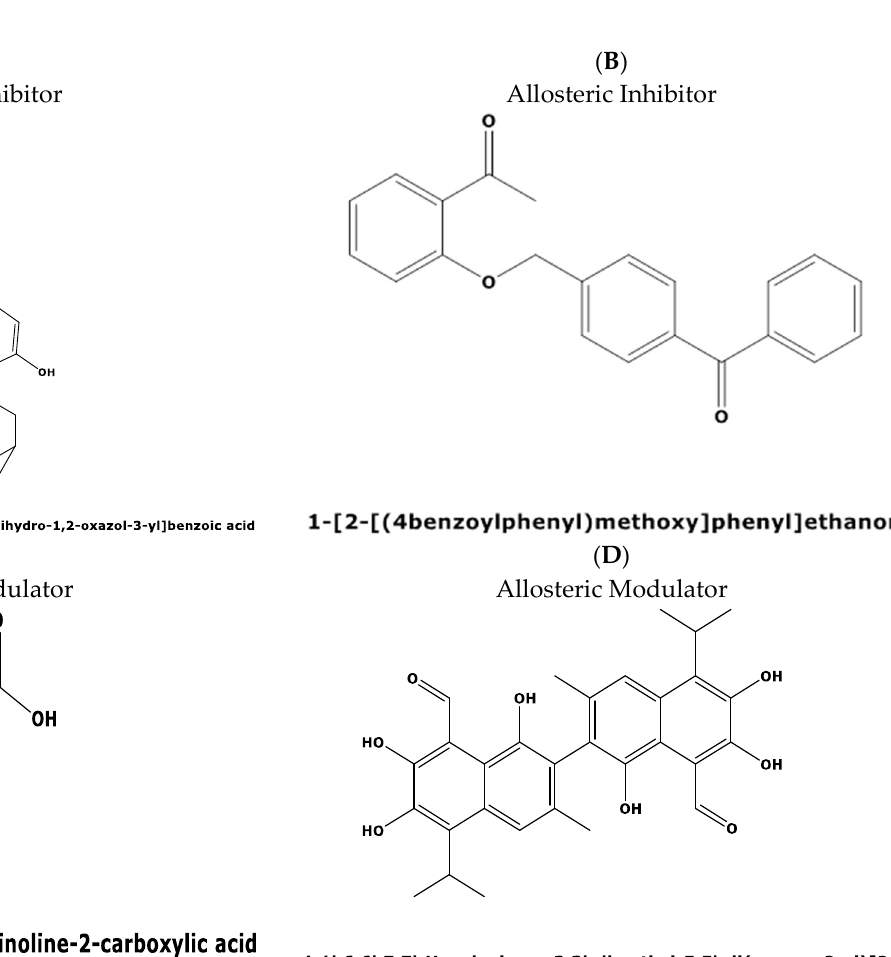
Figure 8. Predicted allosteric modulators and similar allosteric metabolites for binding pockets 1 and 2 in the plasmodial DHS protein obtained from the Allosteric Database and Allobase. ( A ) 4-[5-[3-(1-adamantyl)-4-hydroxyphenyl]-4,5-dihydro-1,2-oxazol-3-yl]benzoic acid with the top Alloscore of 8.61. ( B ) 1-[2-[(4benzoylphenyl)methoxy]phenyl)]ethanone is an allosteric inhibitor with an Alloscore of 8.02. ( C ) Xanthurenic acid (4,8-Dihydroxyquinoline-2-carboxylic acid represents a known, endogenous metabolite to the allosteric inhibitor A. ( D ) Data mining in the Allobase shows significant similarity of compound B to Gossypol ( 1,1′,6,6′,7,7′, - Hexahydroxy - 3,3′ - dimethyl - 5,5′ -( dipropan - 2 - yl )[ 2,2′ - binaphtalene ]- 8,8′ - dicarbaldehyde ) as an allosteric modulator .